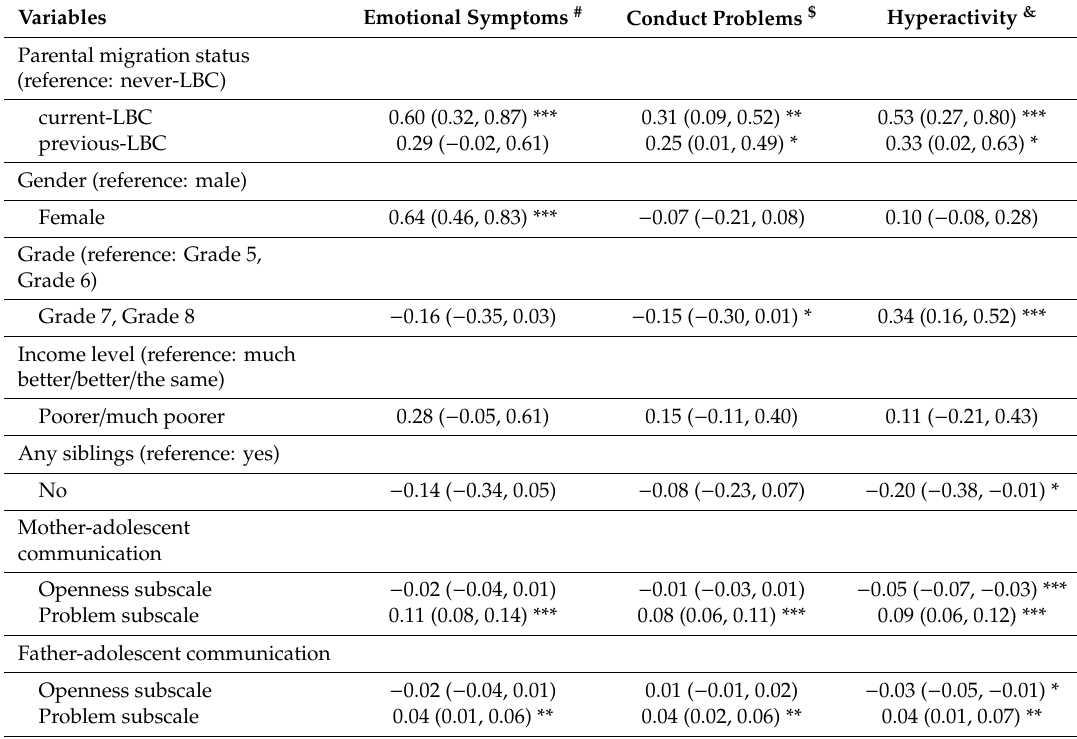
Table 3. Regression analysis for SDQ (emotional symptoms, conduct problems, hyperactivity) by type of child, parent-adolescent communication, and demographic characteristic.